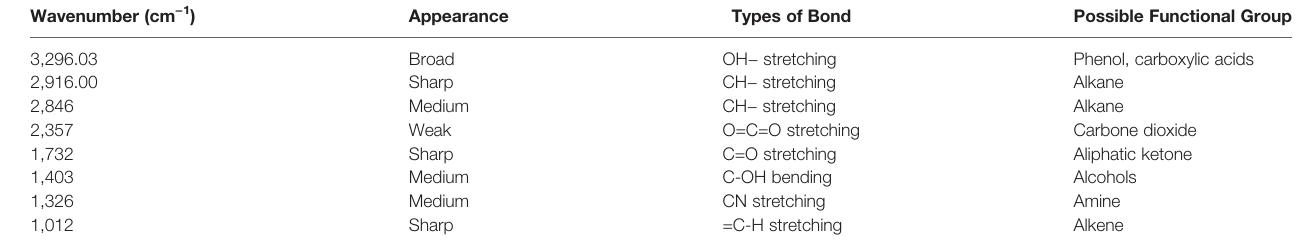
TABLE 3 | FTIR analysis of probable functional group present in U. indica